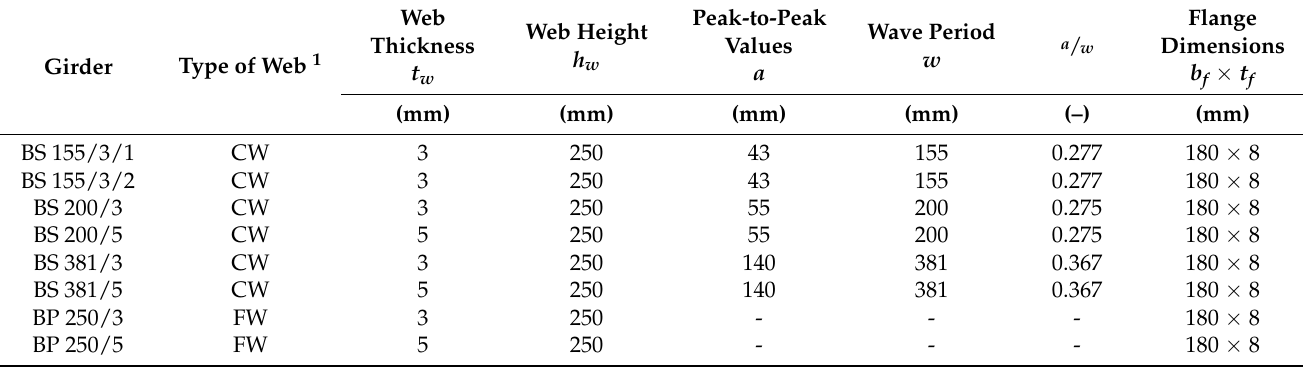
Table 1. Dimensions of tested plate girders.